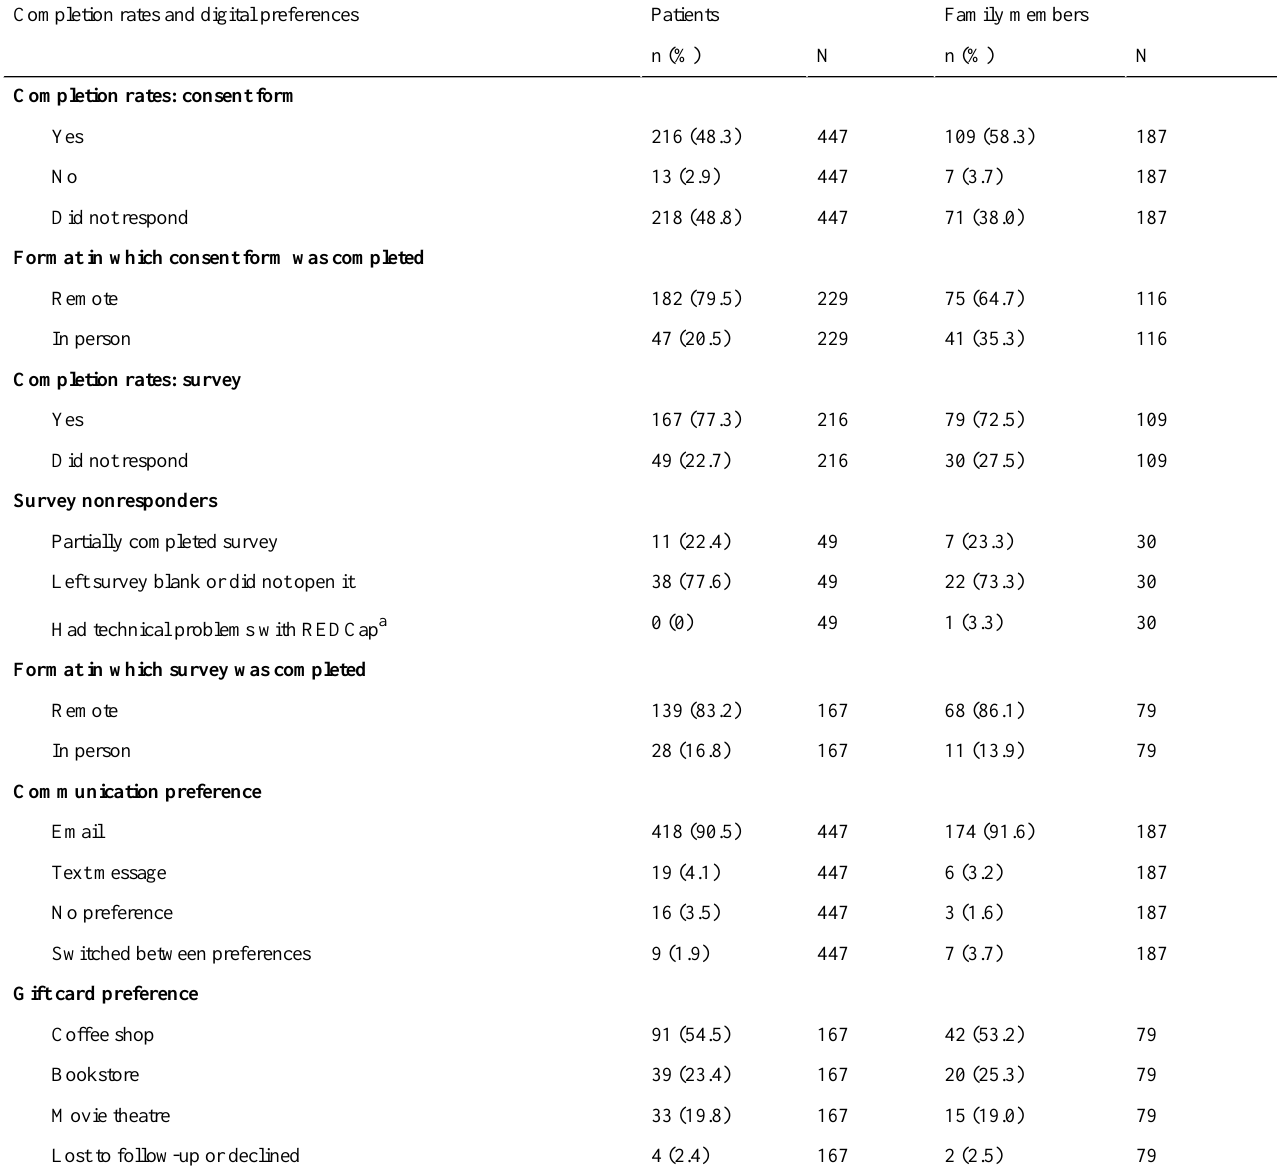
Table 1. Consent and survey completion rates and digital preferences.